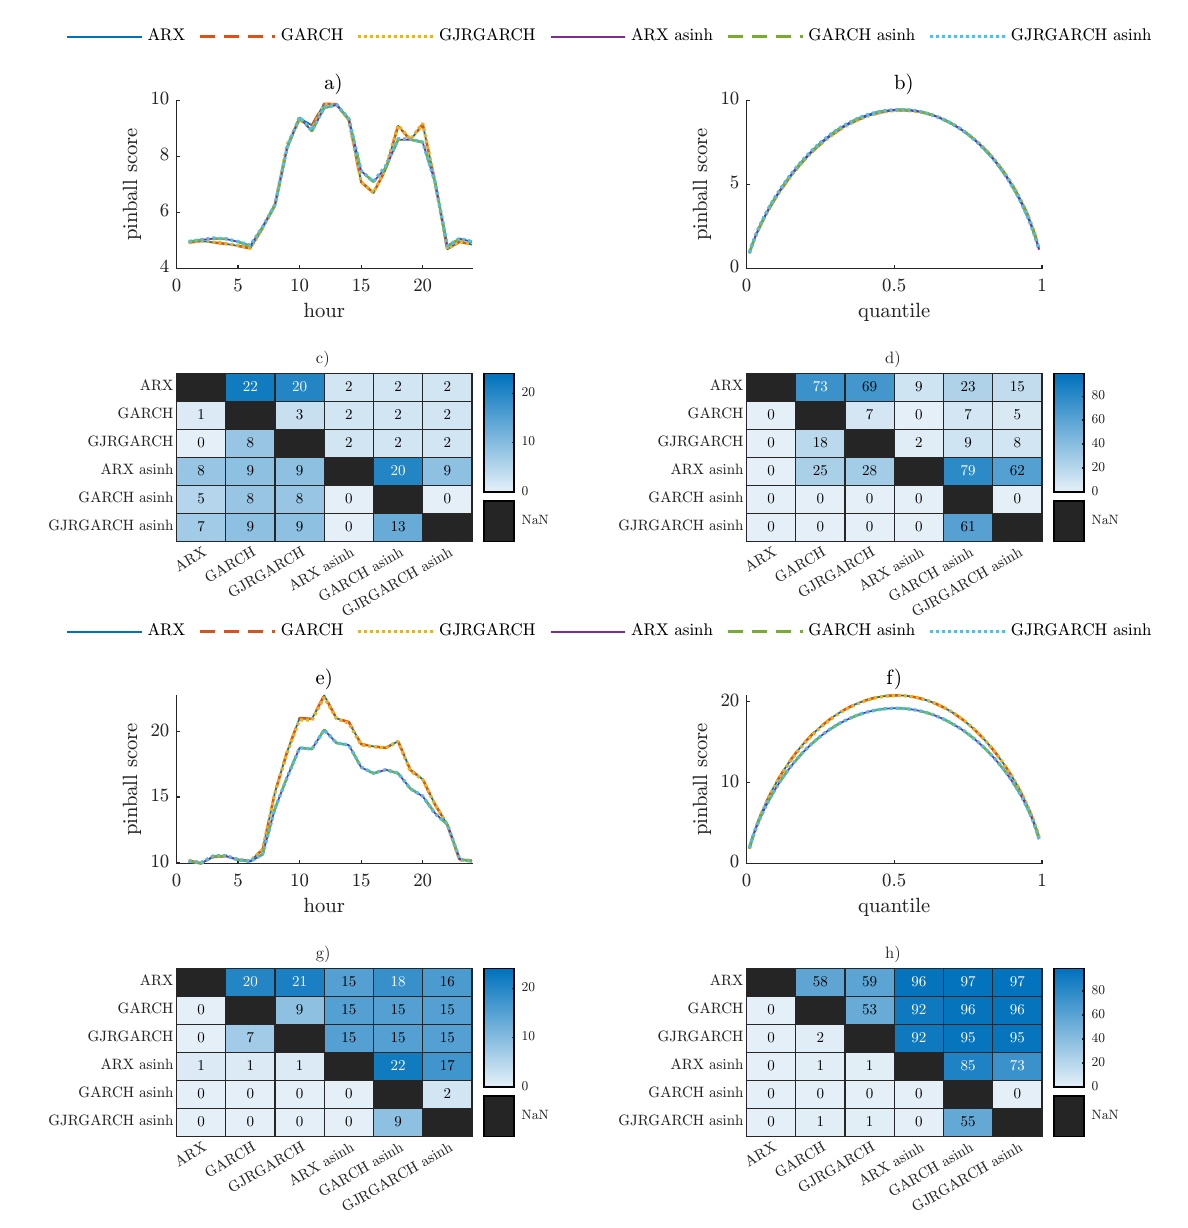
Figure 4. Pinball scores obtained for probabilistic forecasts of the Polish day-ahead (panels ( a – d )) or balancing (panels ( e – h )) electricity prices using ARX, GARCH and GJRGARCH models with or without asinh transformation. The mean score over all percentiles for each hour is plotted in the left panels (( a )—for day-ahead and ( e )—for balancing), while the mean over hours for each quantile in the right panels (( b )—for day-ahead and ( f )—for balancing). The corresponding, aggregated, one- sided Diebold–Mariano test results are given in the corresponding bottom panels ( c , d , g , h ). Source: Authors’